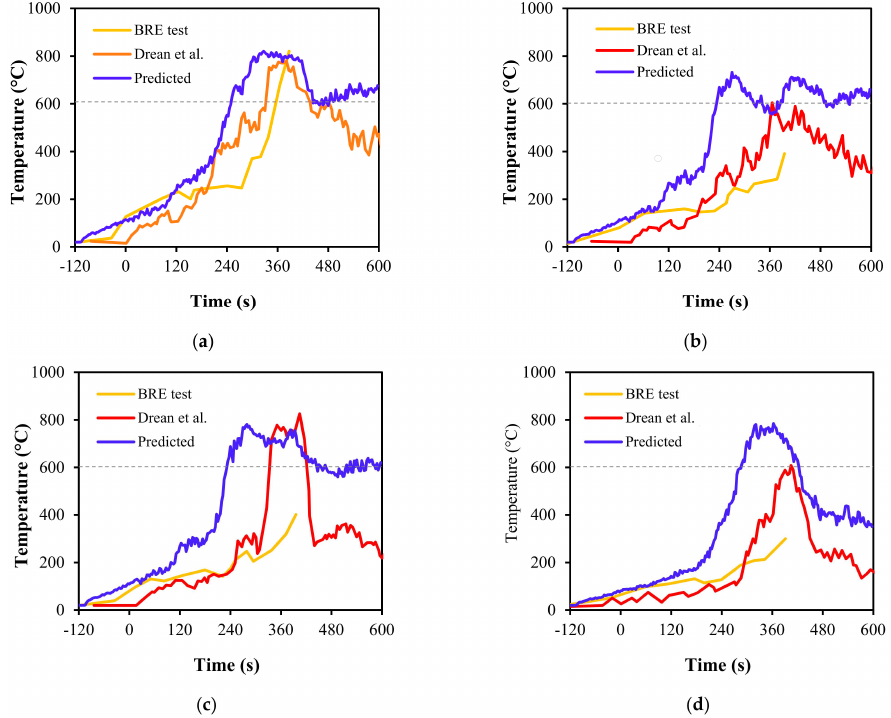
Figure 7. Comparison of test and predicted temperatures of centrally positioned thermocouples